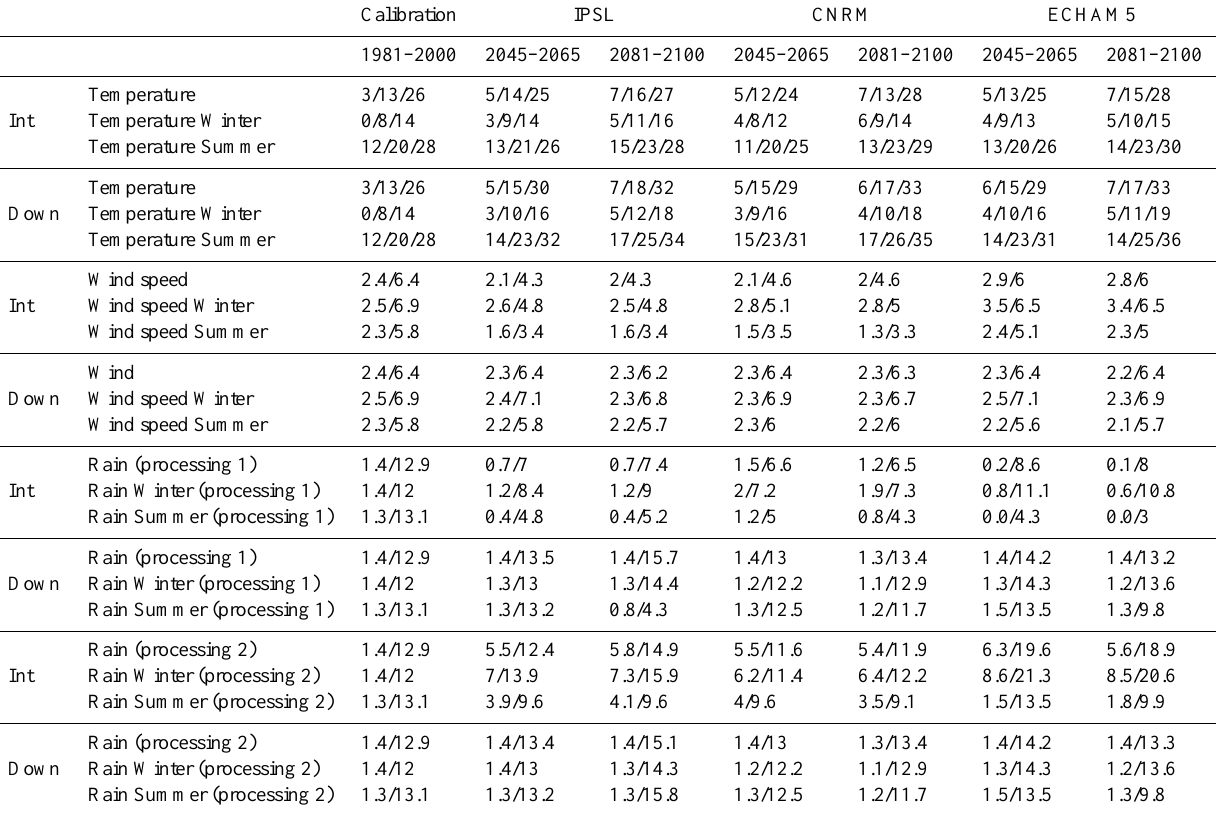
Fig. 7: Probability of having a temperature during the 2081-2100 period that exceeds the 95% quantile of temperature over the calibration period (1981-2000) for the whole year (a), winter (b) and summer (c).